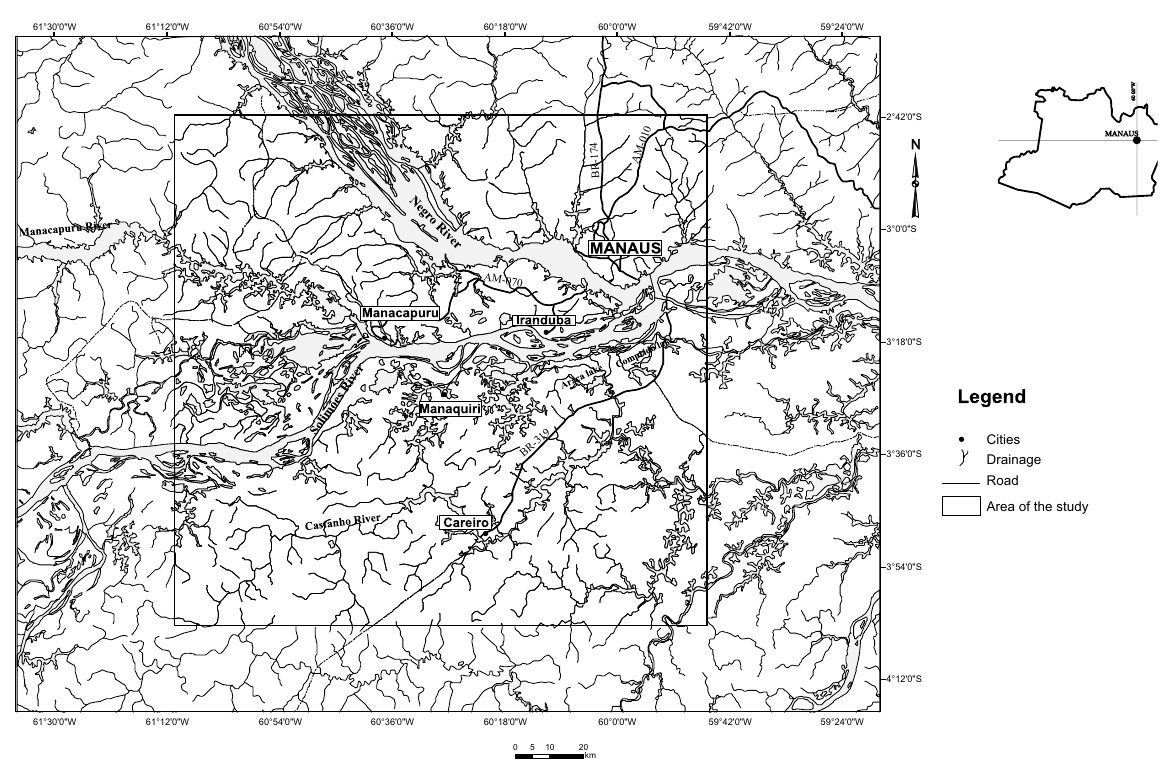
Fig. 1 – Map of the location of the study area (southwest of the city of